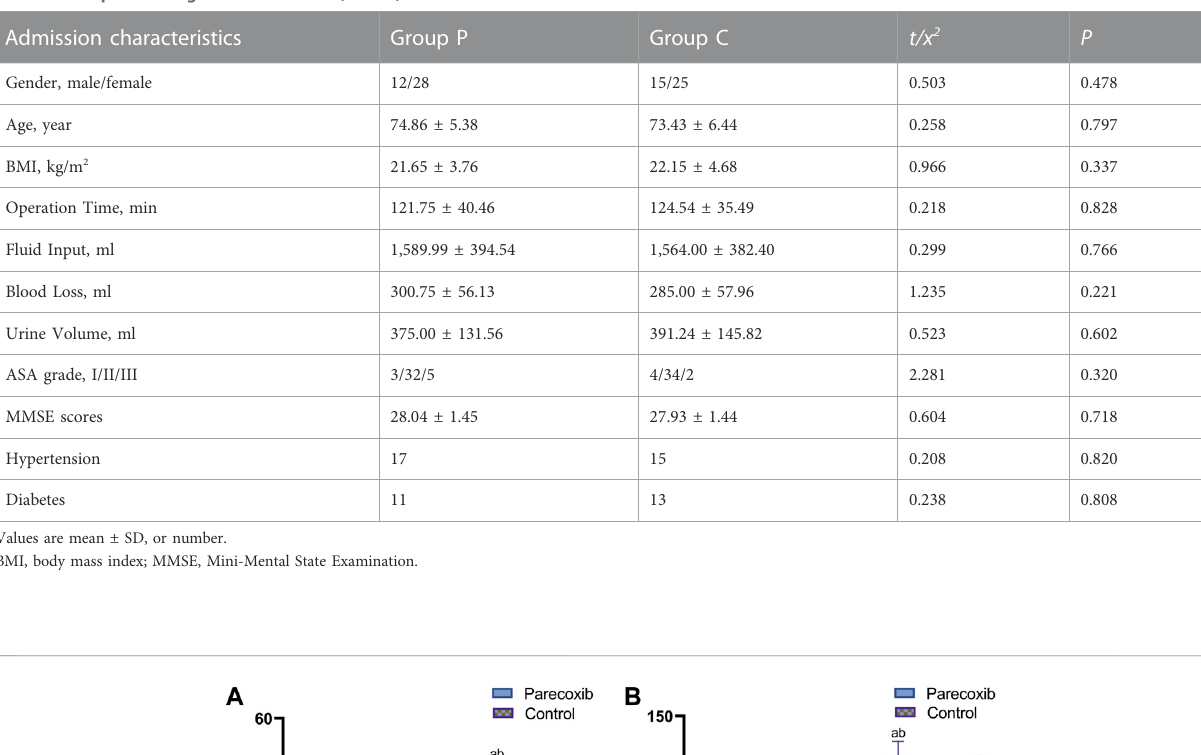
Compared with those at T 0 , the VAS scores at T 3 , T 4 , and T 5 were signi fi cantly decreased ( p < 0.05). Compared with those at T 3 , the VAS scores decreased at T 4 and T 5 ( p < 0.05). Compared with those at T 4 , the VAS scores decreased signi fi cantly at T 5 ( p < 0.05). Intergroup comparison revealed that the difference between the two groups in VAS scores at T 1 were not statistically signi fi cant ( p > 0.05), while the VAS scores at T 3, T 4, and T 5 were signi fi cantly lower in group P than those in group C ( p < 0.05).